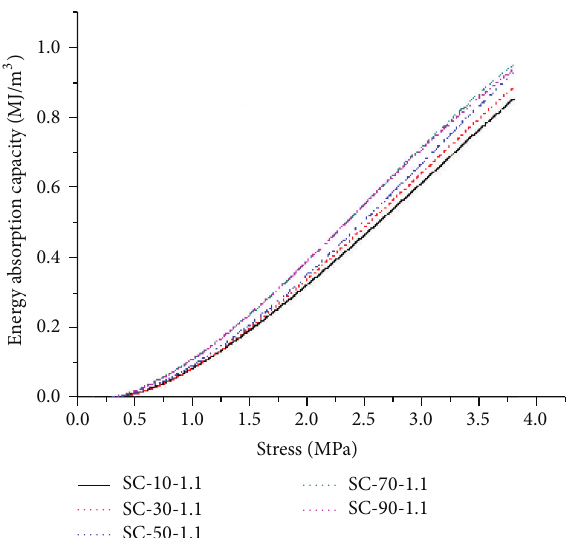
Figure 7: Energy absorption capacity of the